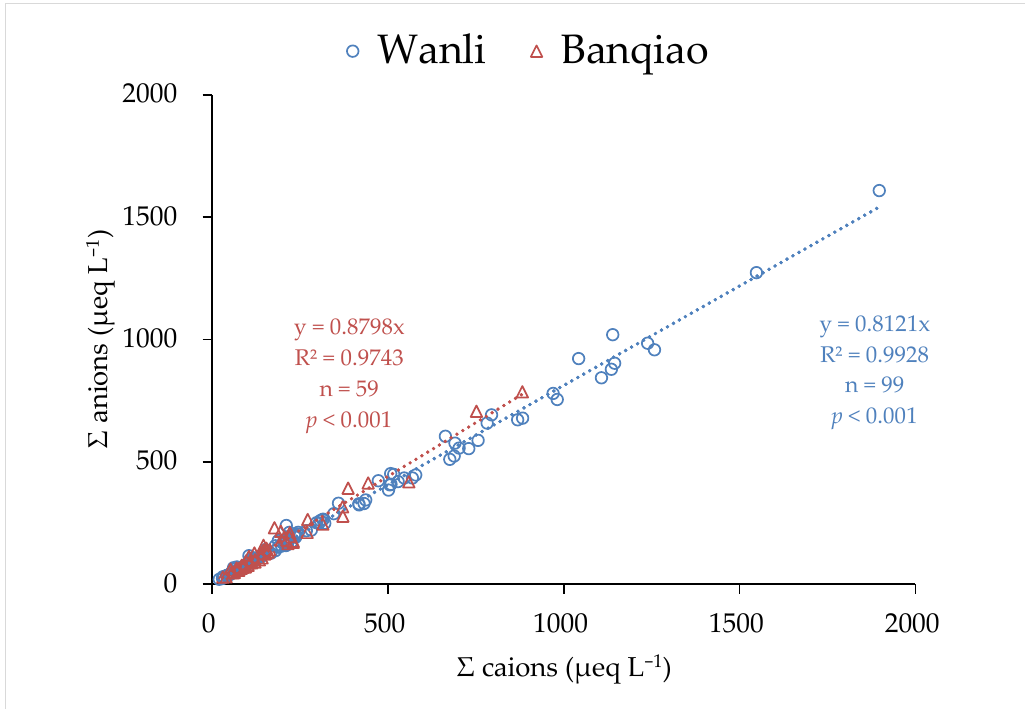
Figure 2. Relationship between the sum of cations and anions (μeq L −1 ).